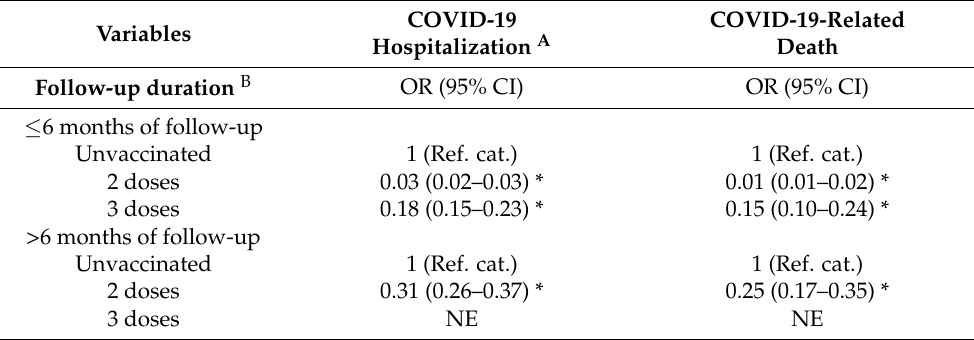
Table 4. Multivariable analysis ψ predicting vaccine effectiveness to prevent COVID-19 hospitaliza- tion or death among the infected subjects, according to the duration of